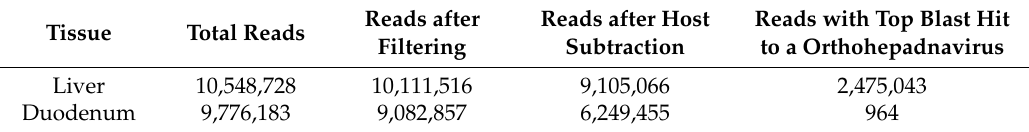
Table 1. Read processing of samples containing hits to a